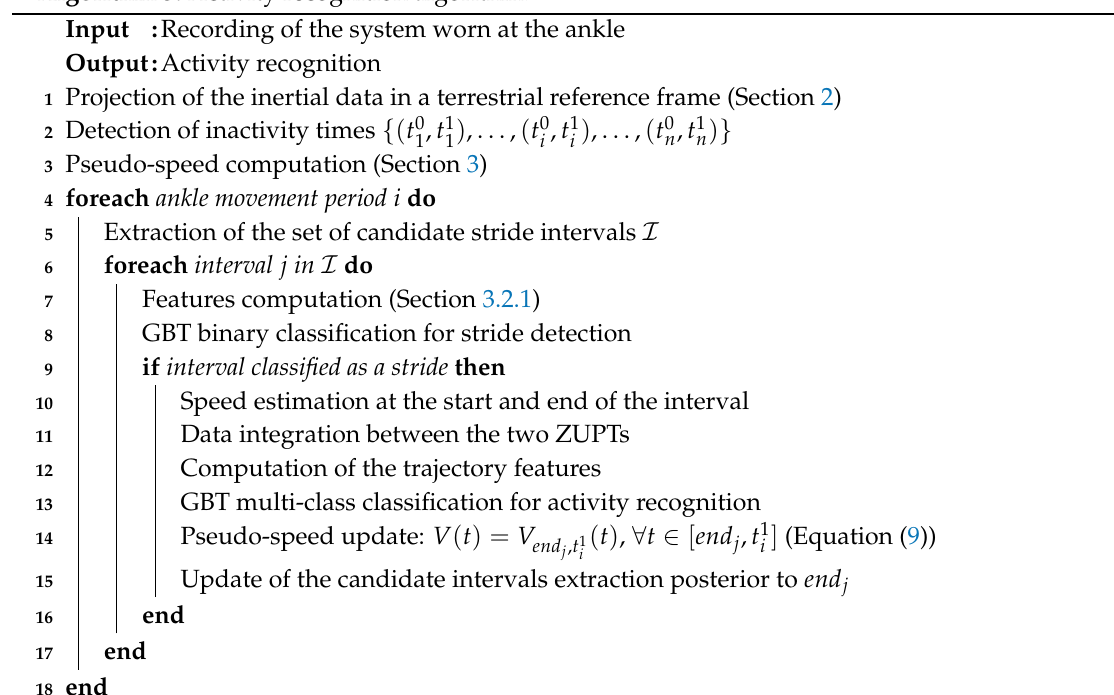
Algorithm 3: Activity recognition algorithm.